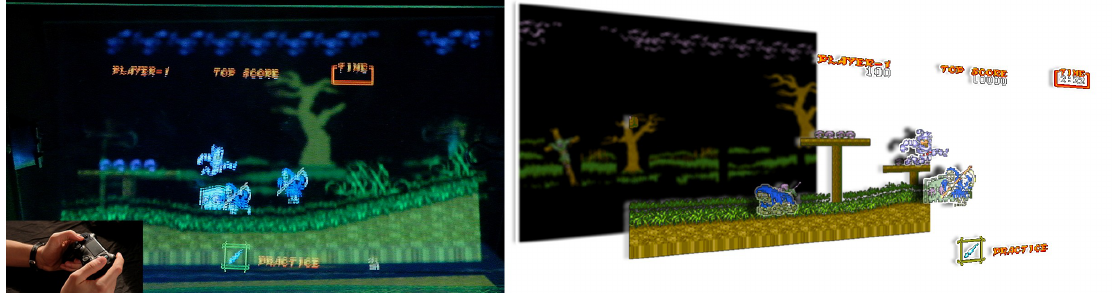
Figure 14. User playing to Ghosts’N Goblins TM videogame sliced on multiple layers.